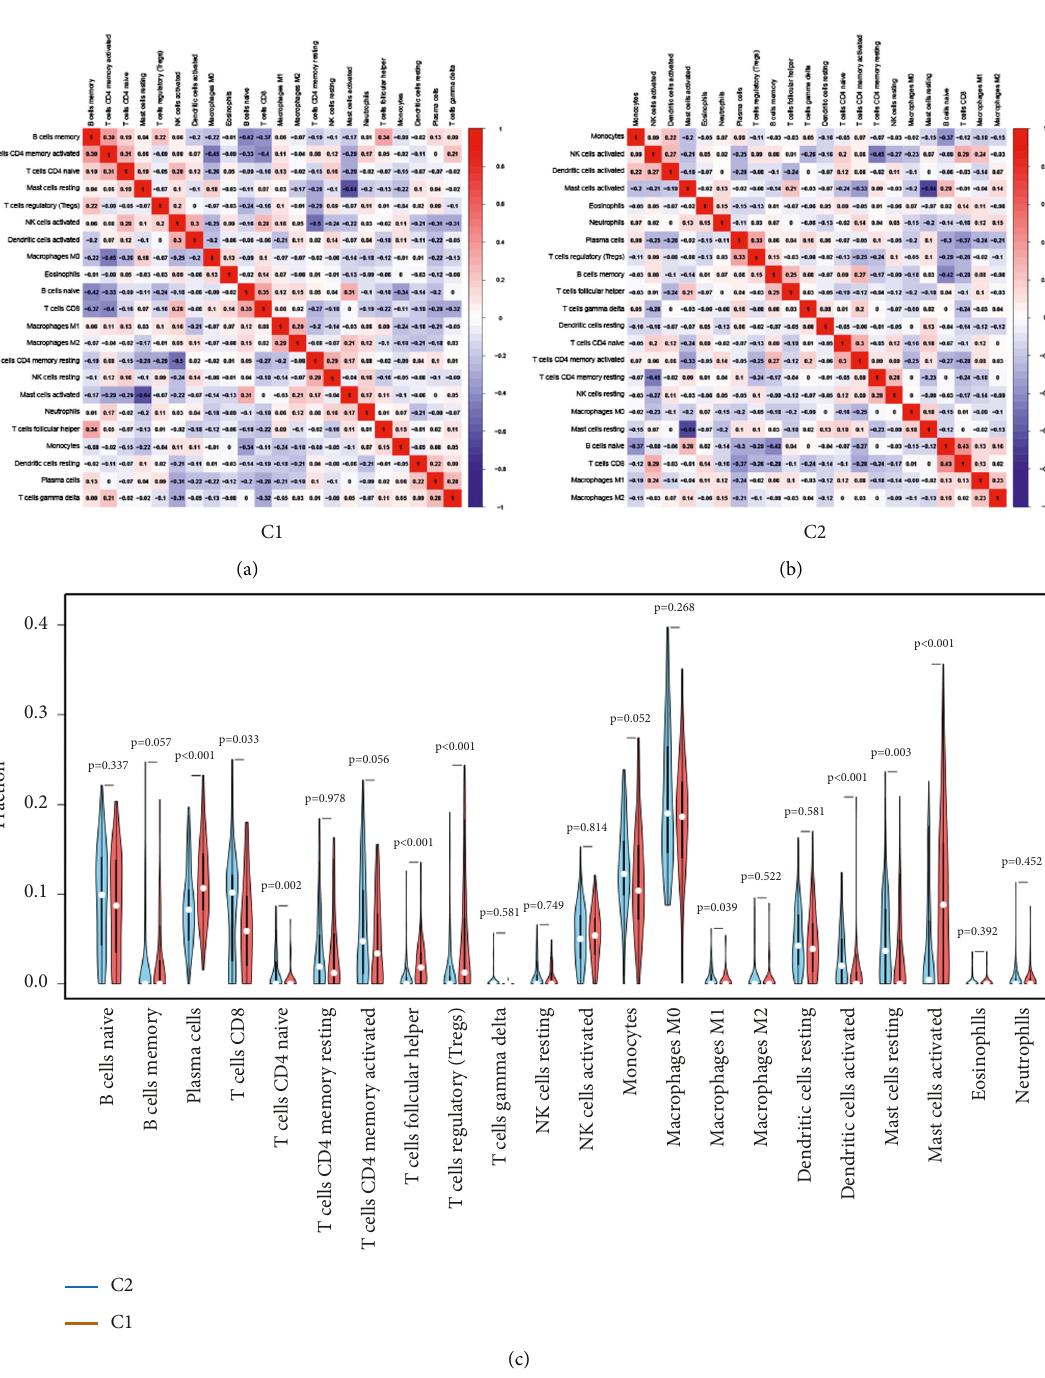
Figure 5: The difference of 22 immune cell infiltration proportions between C1 and C2. (a) The correlation matrix for 22 immune cell proportions in C1. (b) The correlation matrix for 22 immune cell proportions in C2. Red means positive correlation, blue means negative correlation, and the darker the color, the stronger the correlation. (c) Distribution of immune cells between C1 and C2. P values show the significance of